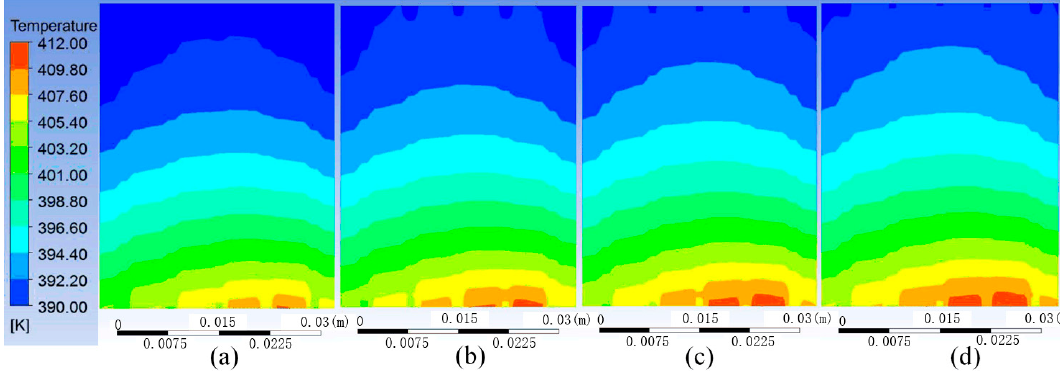
Figure 10. The temperature fields of cross sections at ( a ) z = 3.5 mm, ( b ) z = 10.5 mm, ( c ) z = 17.5 mm, and ( d ) z = 24.5 mm.